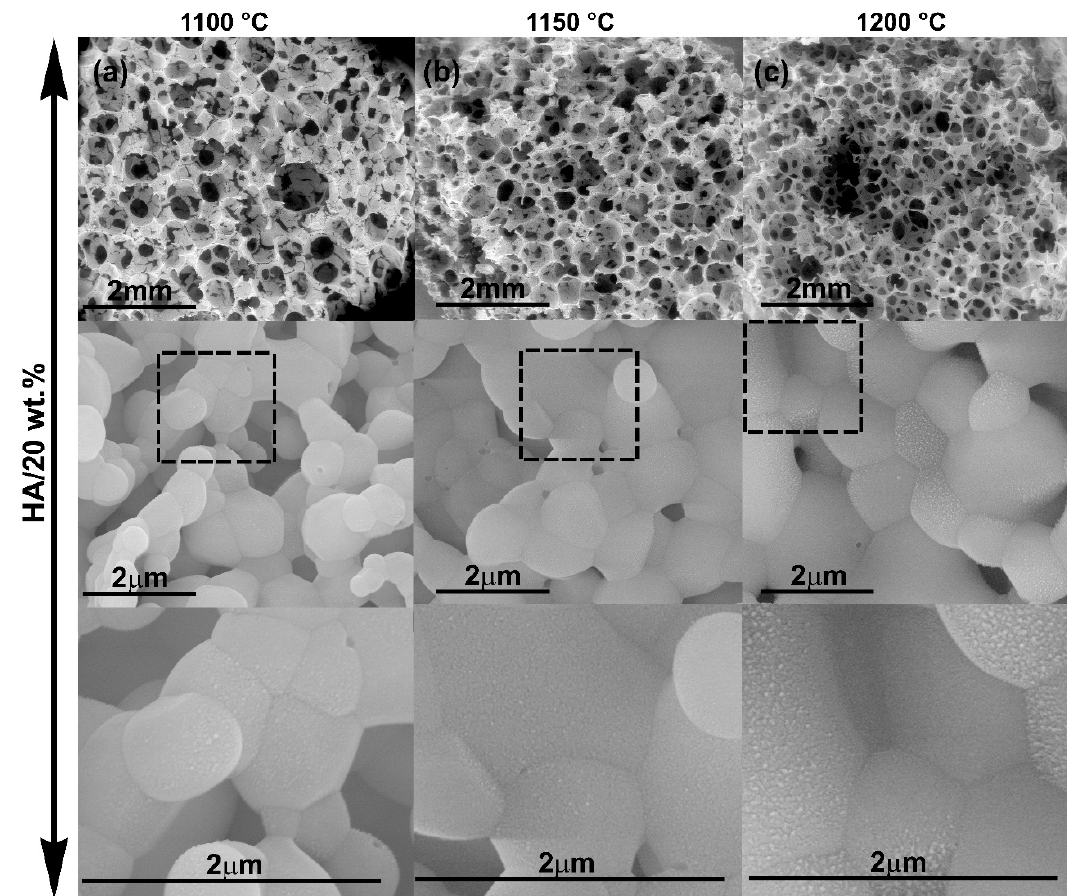
Figure 11. FESEM micrographs of HA scaffolds after 30 days of soaking in SBF at different magnification. The scaffolds had 20 wt.% of slurry solid content and were sintered at different temperatures ( a ) 1100 ◦ C, ( b ) 1150 ◦ C and ( c ) 1200 ◦ C.